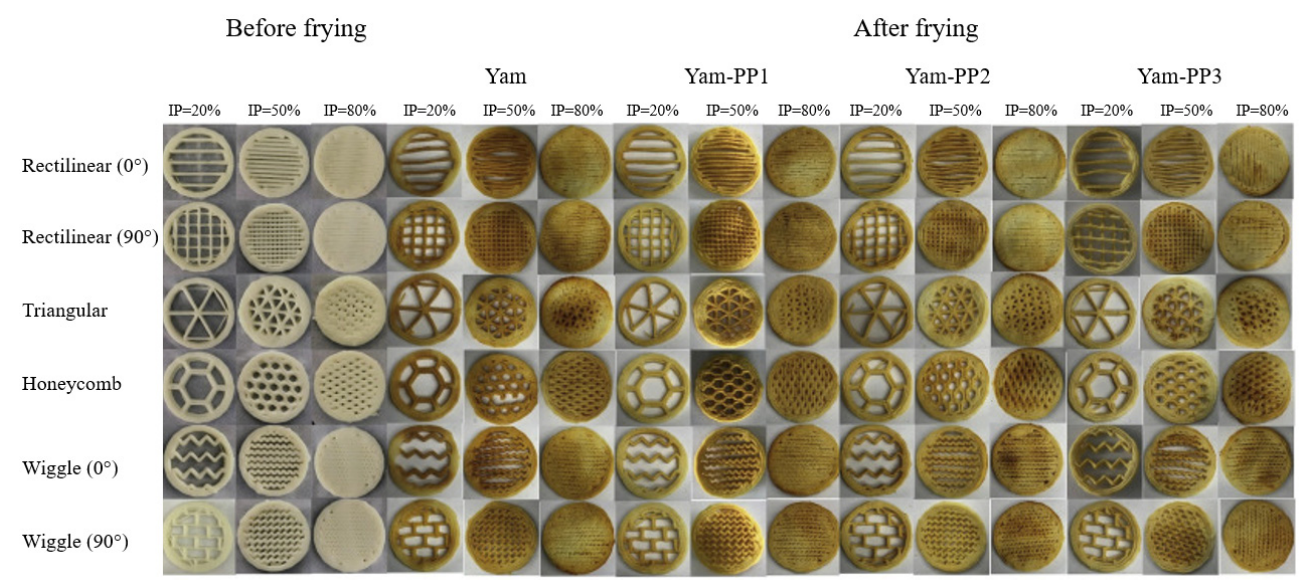
Figure 2. Effect of the addition of potato-processing by-product (PP) on 3D-printed yam snacks before and after post-processing in various combinations (yam/PP = 9:1, 8:2, and 7:3) with different infill percentage levels (20%, 50%, and 80%) “Reprinted/adapted with permission from Ref. [58].